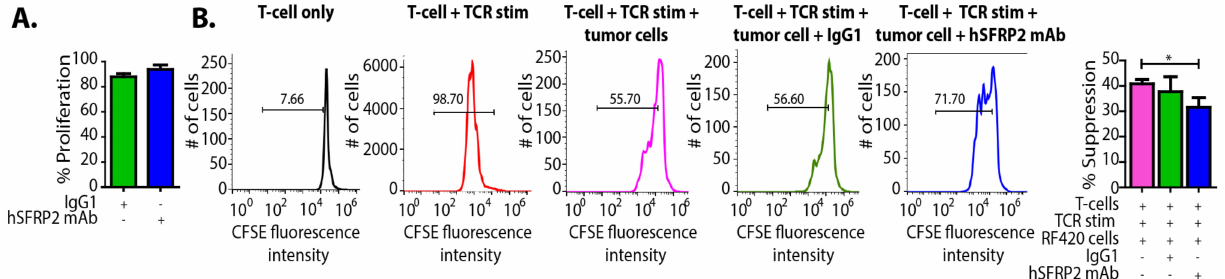
Figure 8. Tumor-induced suppression of T-cells is reversed with hSFRP2 mAb treatment. ( A ) RF420 cells were plated at 3000 cells/well and incubated with either IgG1 control (10 µ M) or hSFRP2 mAb (10 µ M) for 72 h ( n = 6). The number of healthy cells was assessed using Cyquant Direct Cell Proliferation Assay. This shows that hSFRP2 mAb does not directly affect RF420 cell viability. ( B ) T-cells were prelabeled with CFSE dye and then cultured for three days alone, with TCR-stimulation or in the presence of RF420 cells, under the following conditions: T-cells alone (far left, black ); anti-CD3 and anti-CD28 antibodies (TCR) ( red ); TCR and co-culture with RF420 cells ( pink ); TCR stimulated T-cells co-cultured with RF420 cells that were treated with either 10 µ M IgG1 control ( green ) or 10 µ M of hSFRP2 mAb ( blue ). Intensity was measured for each condition using a FACS analysis. Stimulation with TCR alone was used as a positive control for this experiment. Bar graph : percent suppression of CD8 + T-cells was calculated based on the division index method. The division index is calculated by multiplying the proliferation index by the percentage of divided cells and thus represents the division status of the entire population. The experiments were repeated thrice. The histograms display representative analyses of CD8 + T-cells, while the bar graph represents cumulative data from all repeats ( n = 3, * p <